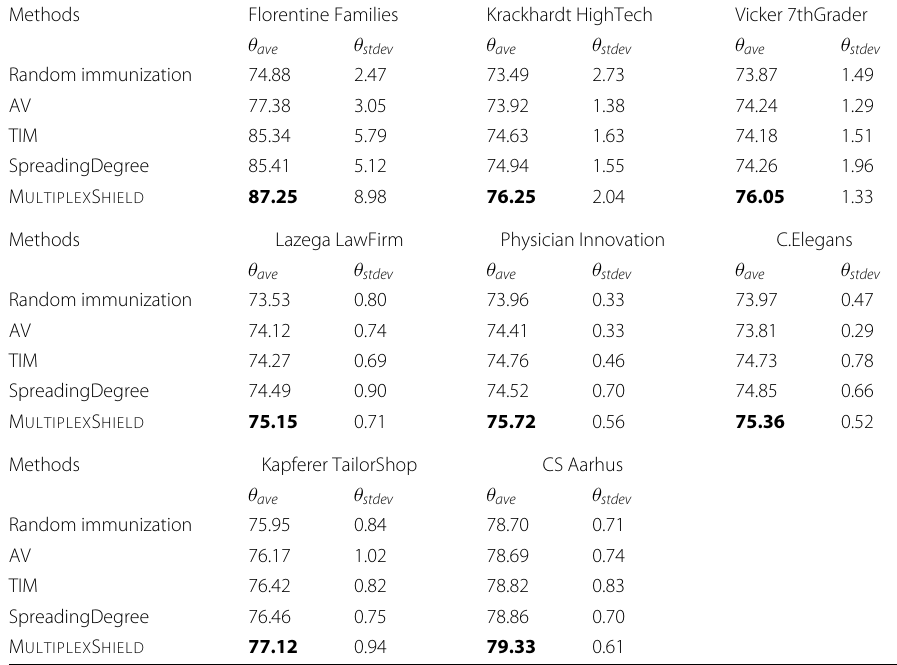
Table 4 Layer-based protection scheme, random nodes attack scenario